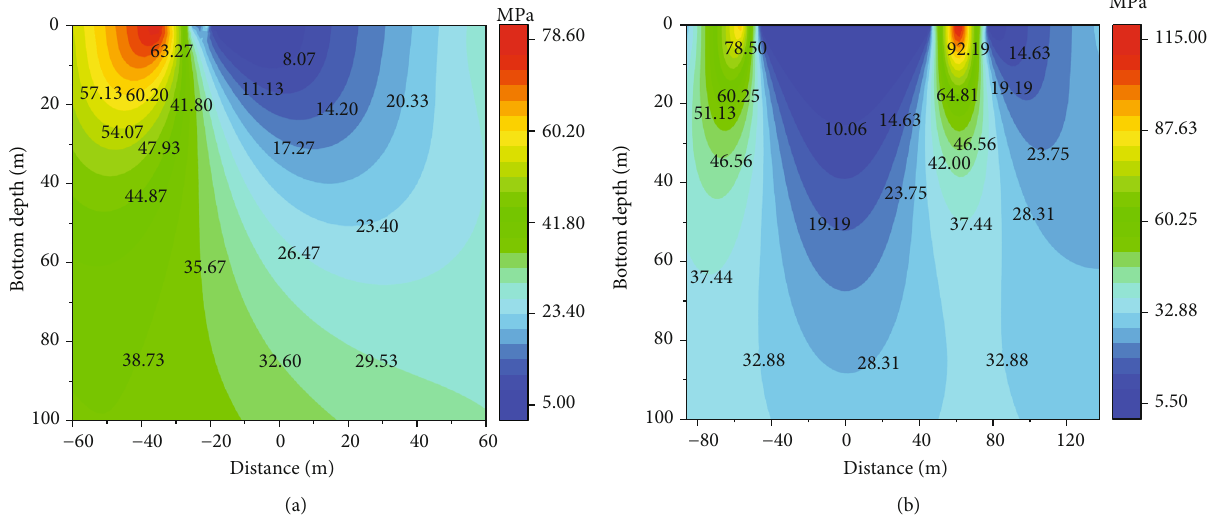
Figure 6: The isoline of the vertical stress: (a) along the inclination; and (b) along the strike.